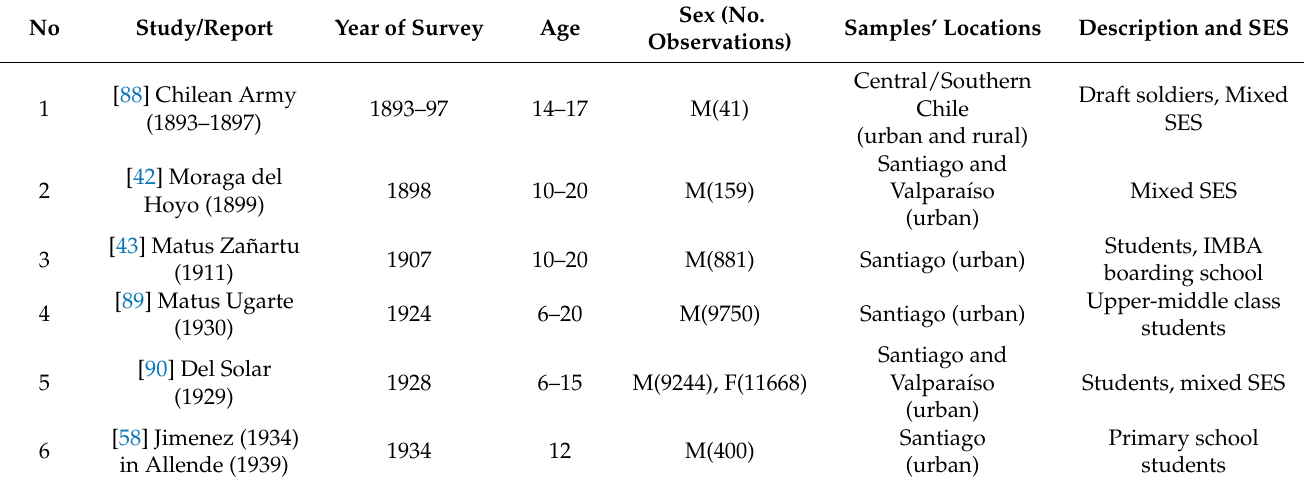
Table A1. Studies providing height-for-age of samples of boys and girls, Chile